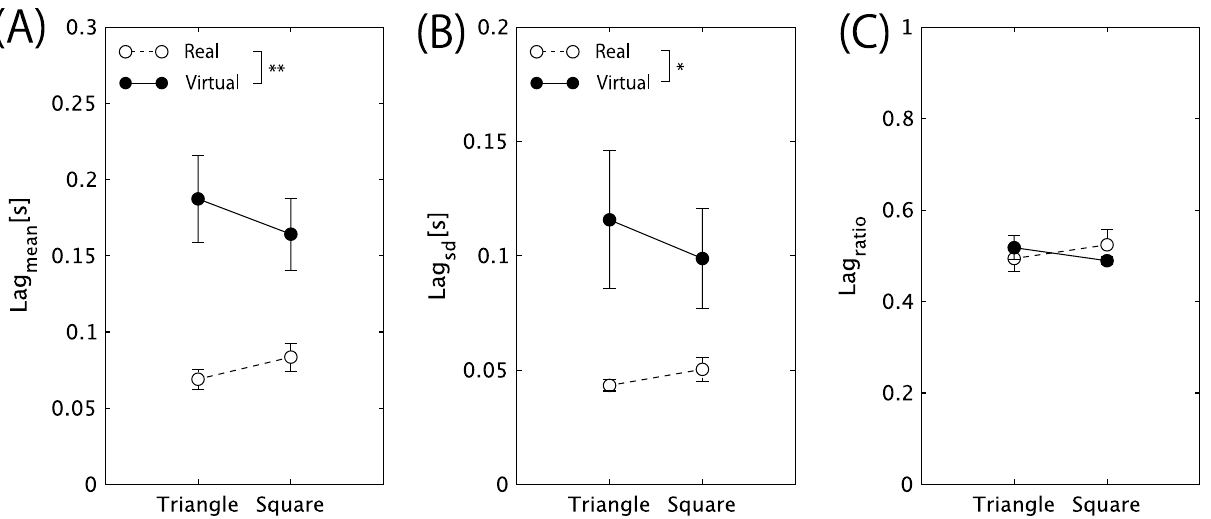
Figure 4. Mean and standard error of timing lag between the leader and followers. ( A ) lag mean , ( B ) lag sd , and ( C ) lag ratio . Broken line with open circle denotes real space, and the solid line with filled circle denotes virtual space. ** and * indicate a significant difference with p < 0.01 and p < 0.05 ,